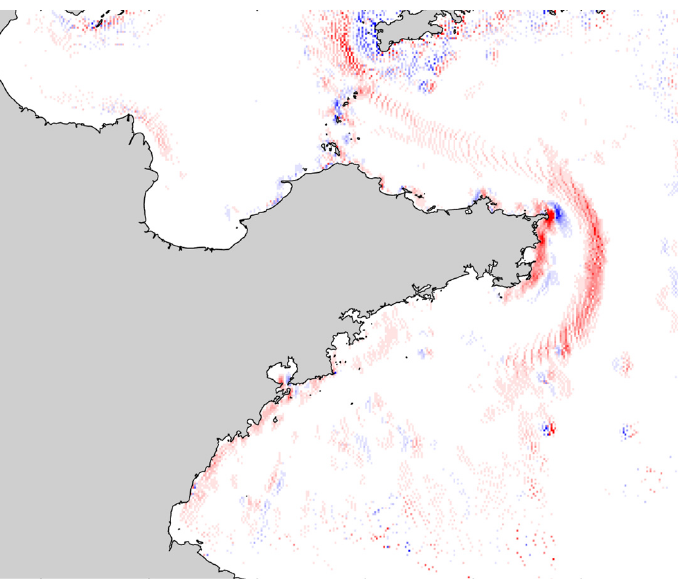
Figure 8 . Terrain slope around Shandong Peninsula. Figure 8. Terrain slope around Shandong